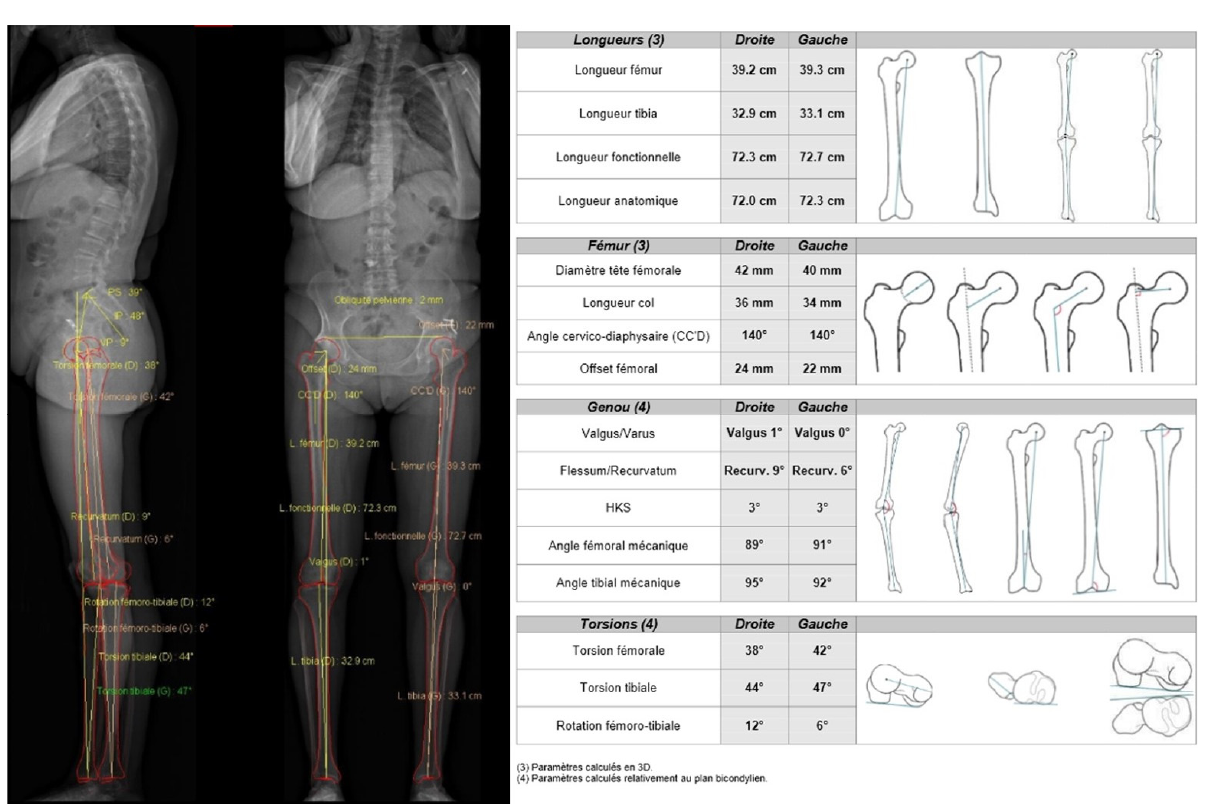
Figure 7. EOS ® imaging example showing pelvic and lower limbs measurements. In this example, pelvic parameters are shown (PS: sacral slope, IP: pelvic incidence, VP: pelvic version), and multiple lower limbs measurements are available (femoral and tibial length, femoral head diameter, femoral neck length, cervico-diaphyseal angle, femoral offset, femoral and tibial version/torsion, knee valgus/varus, hip-knee shaft angle, femoral flessum/recurvatum).